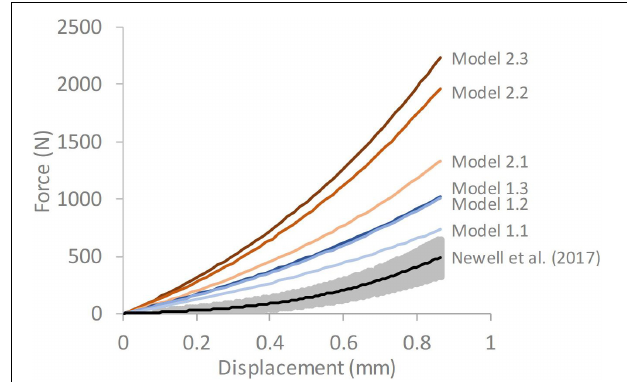
FIGURE 4 | Force-displacement response of each of the six models compared against average experimental response from Newell et al. (2017) The grey shaded region on the experimental data represents ± 1 standard deviation. Model 1.1—simple endplates, linear NP-AF boundary, Model 1.2—simple endplates, curved NP-AF boundary, Model 1.3—simple endplates, segmented NP-AF boundary, Model 2.1—segmented endplates, linear NP-AF boundary, Model 2.2—segmented endplates, curved NP-AF boundary, Model 2.3—segmented endplates, segmented NP-AF boundary.